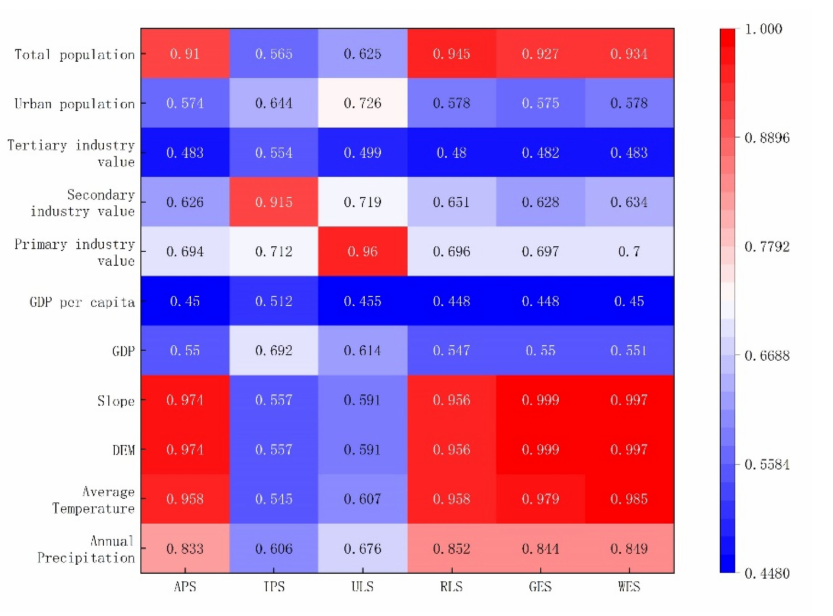
Figure 10. Correlation degree between the PLES and driving